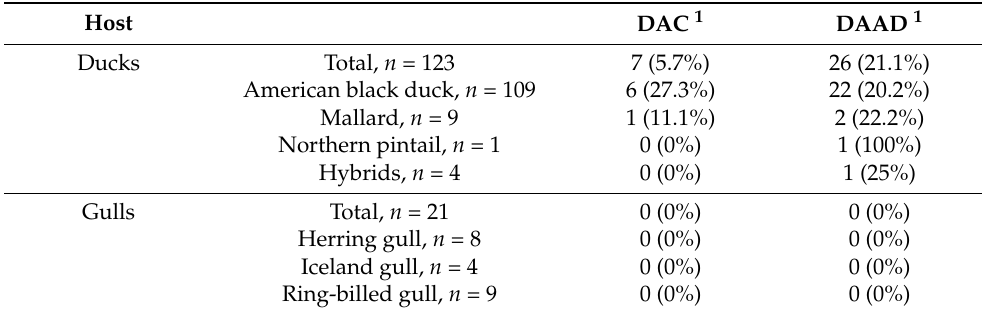
Table 1. Percentage of birds from different species that tested positive for duck-associated chappar- vovirus (DAC) and duck-associated ambidensovirus (DAAD). Host DAC 1 DAAD 1 Ducks Total, n = 123 7 (5.7%) 26 (21.1%) American black duck, n = 109 6 (27.3%) 22 (20.2%) Mallard, n = 9 1 (11.1%) 2 (22.2%) Northern pintail, n = 1 0 (0%) 1 (100%) Hybrids, n = 4 0 (0%) 1 (25%) Gulls Total, n = 21 0 (0%) 0 (0%) Herring gull, n = 8 0 (0%) 0 (0%) Iceland gull, n = 4 0 (0%) 0 (0%) Ring-billed gull, n = 9 0 (0%) 0